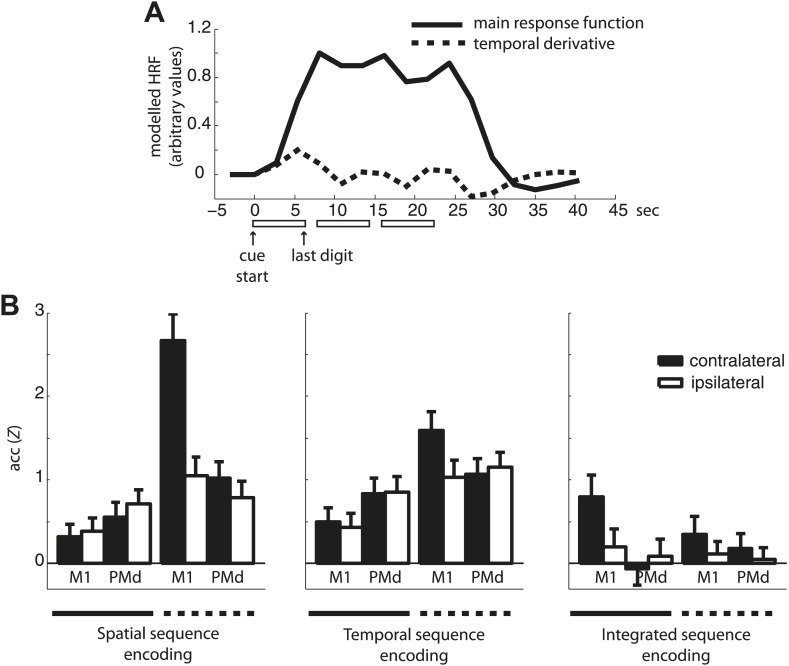
Classification accuracy of the main response function and temporal derivative.(A) An example of the main response function and temporal derivative for three sequence repetitions (one mini-block). Note that in contrast to the temporal derivative that captures the temporal evolution of each sequence by returning to baseline between each sequence, the main response function used in the subsequent classification analysis remains elevated across the three sequence repetitions. (B) Classification accuracy of the main response vs the temporal derivative estimates in contra- and ipsilateral M1 and PMd.